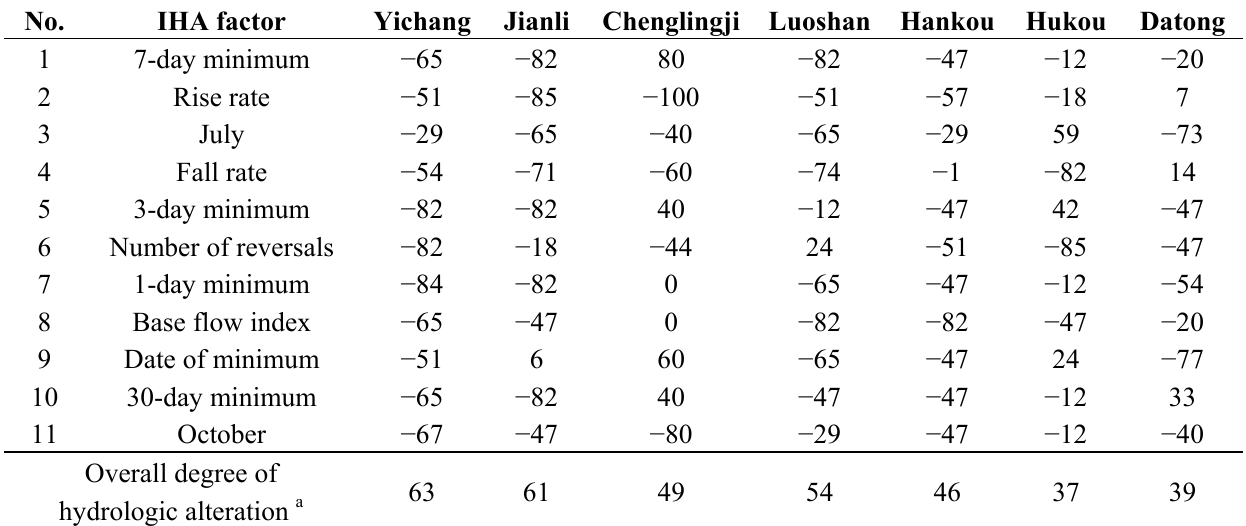
Note: a . Overall degrees of HA are based on the average absolute values of each